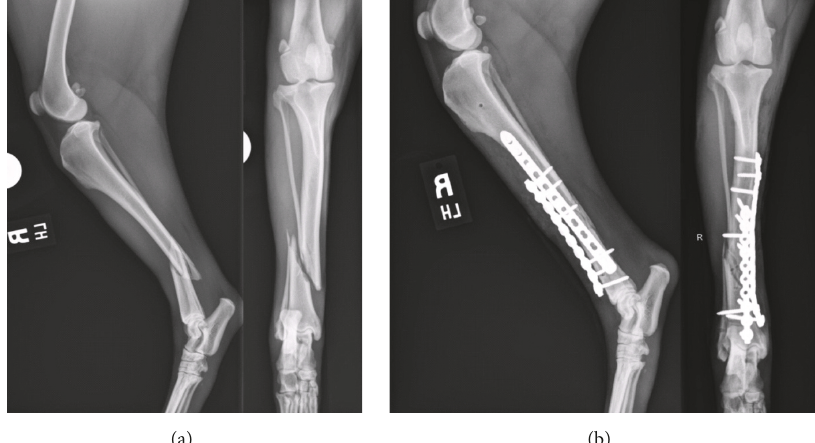
Figure 3: Craniocaudal and mediolateral preoperative radiographs of dog #2’s right tibial and fibula fractures (a). Initial postoperative radiographs following primary surgical stabilization with a 12-hole, 2.7 mm locking compression plate and a 10-hole, 2.7 mm String of Pearls plate